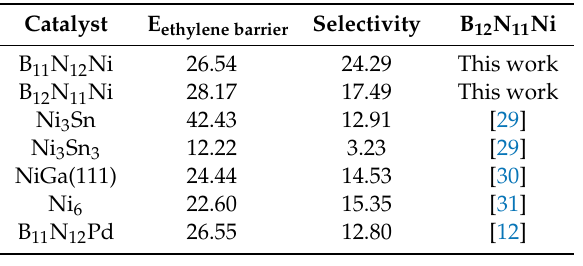
Table S1. The Cartesian coordinates of B12N12 cluster, Table S2. The Cartesian coordinates of B11N12Ni cluster, Table S3. The Cartesian coordinates of B12N11Ni cluster, Table S4. The Cartesian coordinates of acetylene adsorption on B12N12 cluster, Table S5. The Cartesian coordinates of acetylene adsorption on B11N12Ni cluster, Table S6. The Cartesian coordinates of acetylene adsorption on B12N11Ni cluster, Table S7. The Cartesian coordinates of hydrogen adsorption on B12N12 cluster, Table S8. The Cartesian coordinates of hydrogen adsorption on B11N12Ni cluster, Table S9. The Cartesian coordinates of hydrogen adsorption on B12N11Ni cluster, Table S10. The Cartesian coordinates of CO on B12N11Ni cluster, Table S11. The Cartesian coordinates of TS1 on B12N11Ni cluster, Table S12. The Cartesian coordinates of IM1 on B12N11Ni cluster, Table S13. The